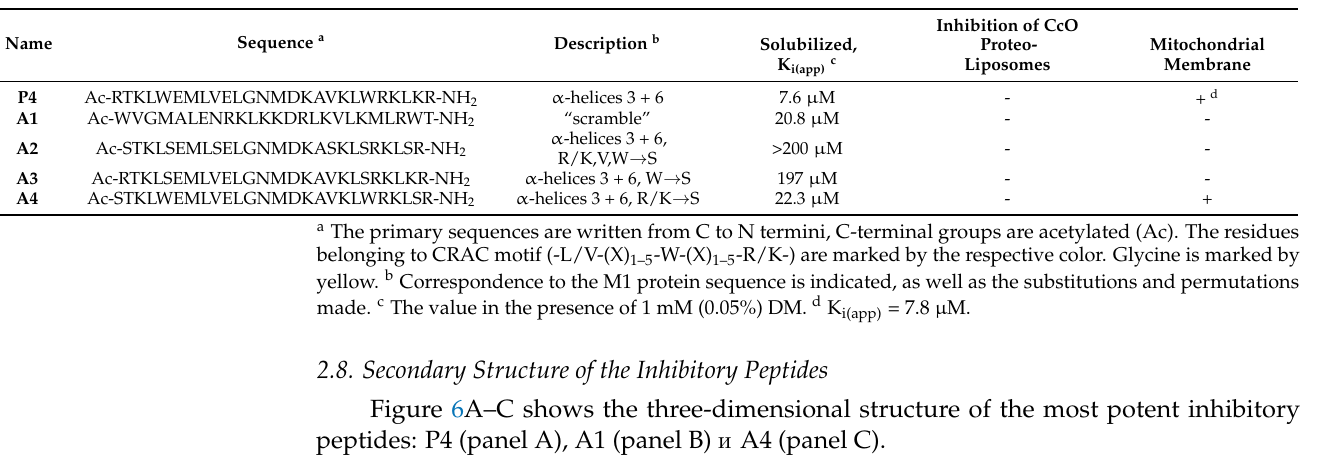
Table 1. Peptides P4 and A1-A4 as inhibitors of CcO.